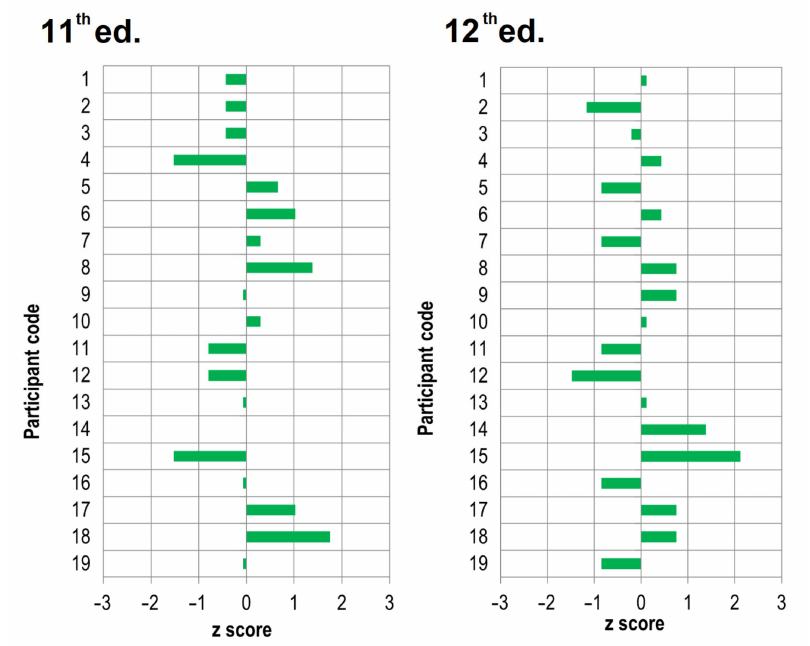
Figure 2. The z-score value for the measurement of tensile adhesion strength after water immersion for each of 19 laboratories participating in the eleventh and twelfth editions of the